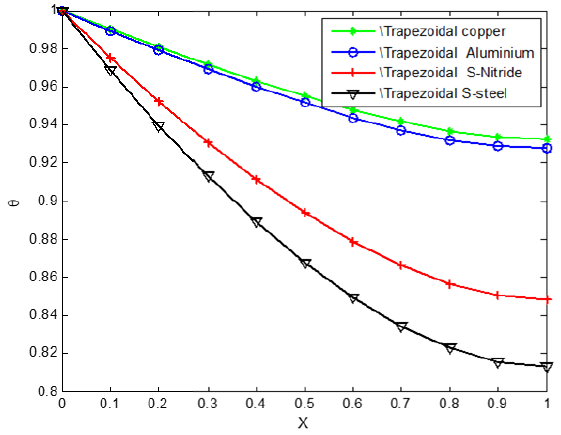
Figure 5. Effect of different materials on non-dimensional temperature distribution of fin with Trapezoidal profile